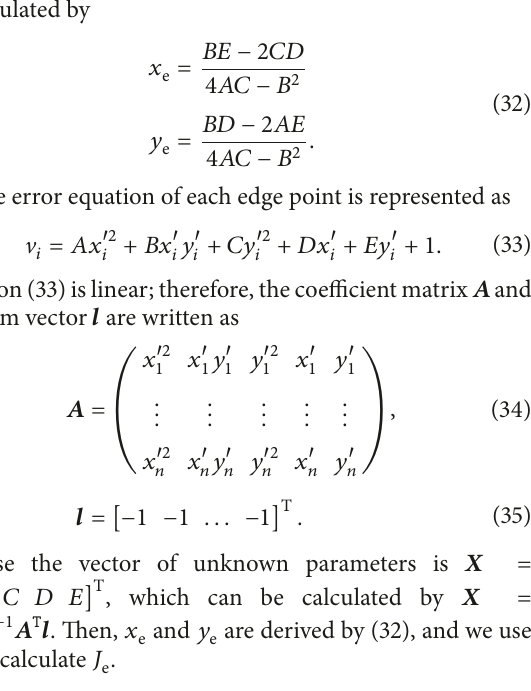
Figure 8: Flow chart of centroid extraction of the sun